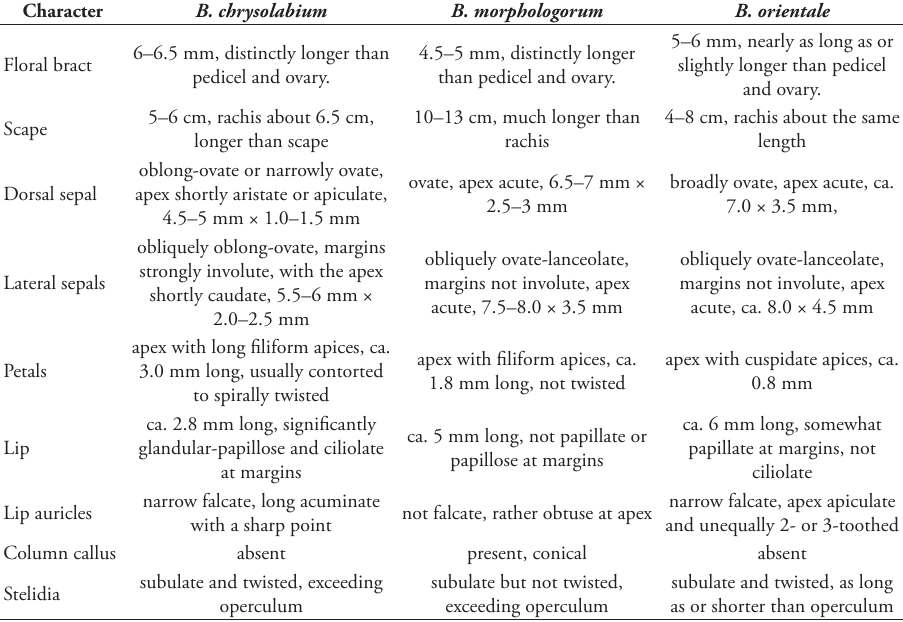
Table 1. Diagnostic morphological characters distinguishing B. chrysolabium from its two allied species.